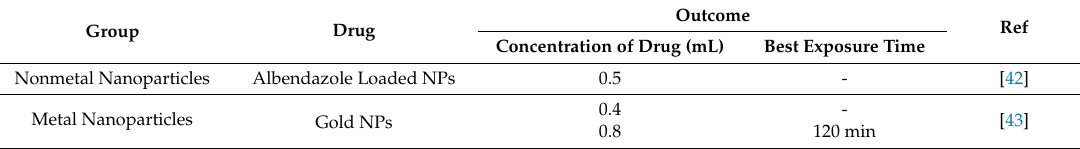
Table 3. A list of ex vivo studies on e ff ects of nanoparticles against hydtid cysts.